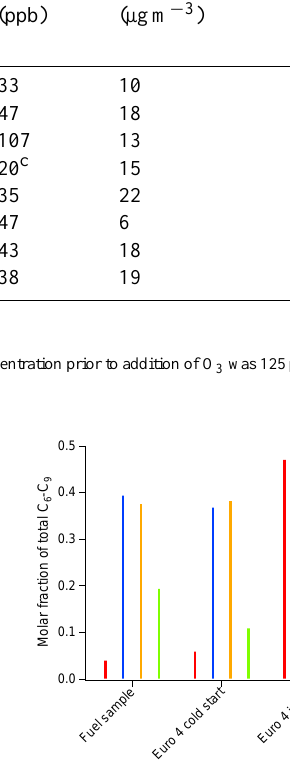
portant C 7 –C 9 light aromatic precursors. The upper panels show the mixing ratios of NO, NO 2 and O 3 (left y-axis) and the ratio of nitrate and OA to sulfate seed (right y-axis). The middle panels show the mixing ratios for the most important light aromatic precursors and one photochemical gas-phase reaction product, obtained by PTR-MS. The PTR-MS chan- nels correspond to toluene (C 7 m / z = 93), C 8 ( m / z = 107), C 9 ( m / z = 121), C 10 ( m / z = 135) aromatics and acetaldehyde ( m / z = 45). In the P1 experiment (Fig. 3b), toluene, m-xylene (C 8 ) and 1,2,4-trimethylbenzene (C 9 ) were used as precur- sors. The lower panels show the H : C and O : C elemental ratios of the formed SOA, derived from AMS